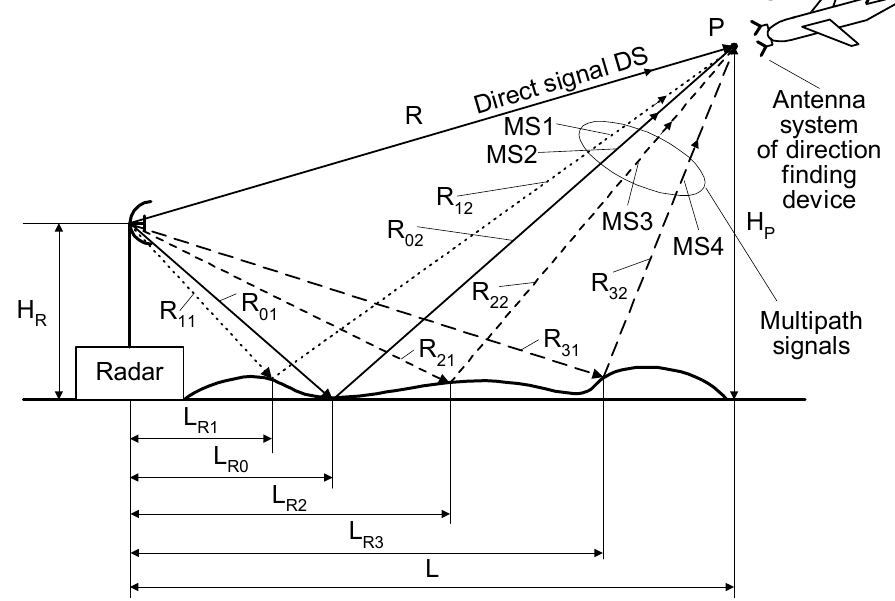
Figure 3. Schematic demonstrating the multipath phenomenon.